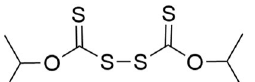
Fig. 14 Typical DIP structure. The compound that contains the xanthate group.